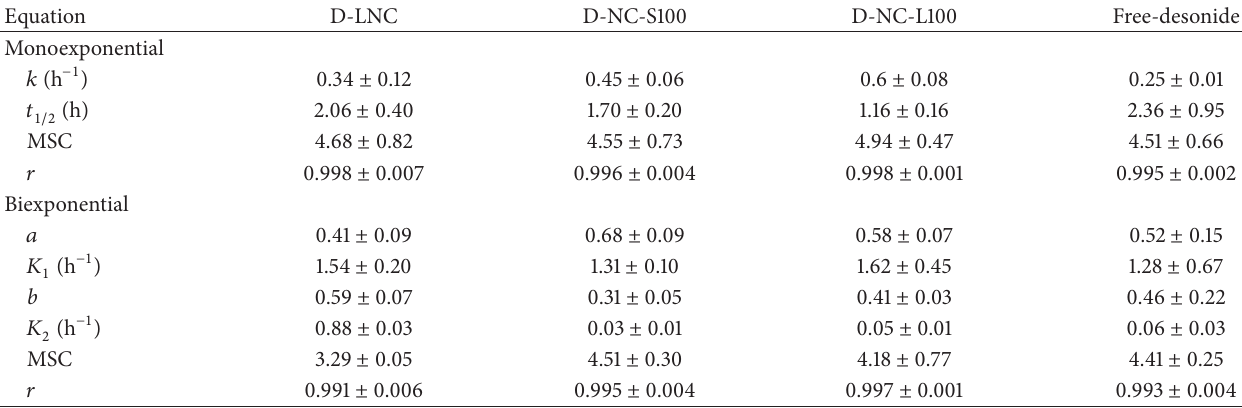
Table 4: Release constants, correlation coefficients, and MSC obtained by fitting the release profiles of desonide using dialysis sac, according to the monoexponential and biexponential